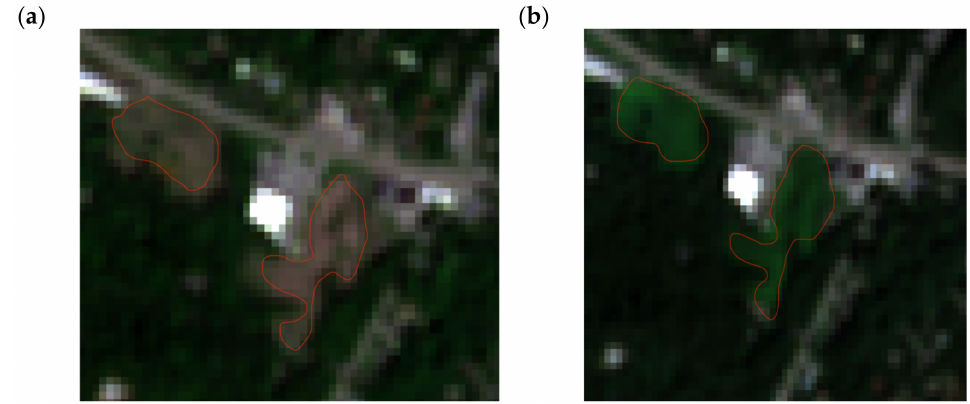
Figure 4. Kudzu patches (marked by red lines) in Sentinel-2 images in spring ( a ) and fall ( b ). The second assumption was that the greenness of kudzu was higher in the late fall image than the early spring image, whereas the greenness of other vegetation was higher in early spring than late fall. We used the normalized difference vegetation index (NDVI) to measure the greenness of the vegetation [35]. NDVI is defined as: